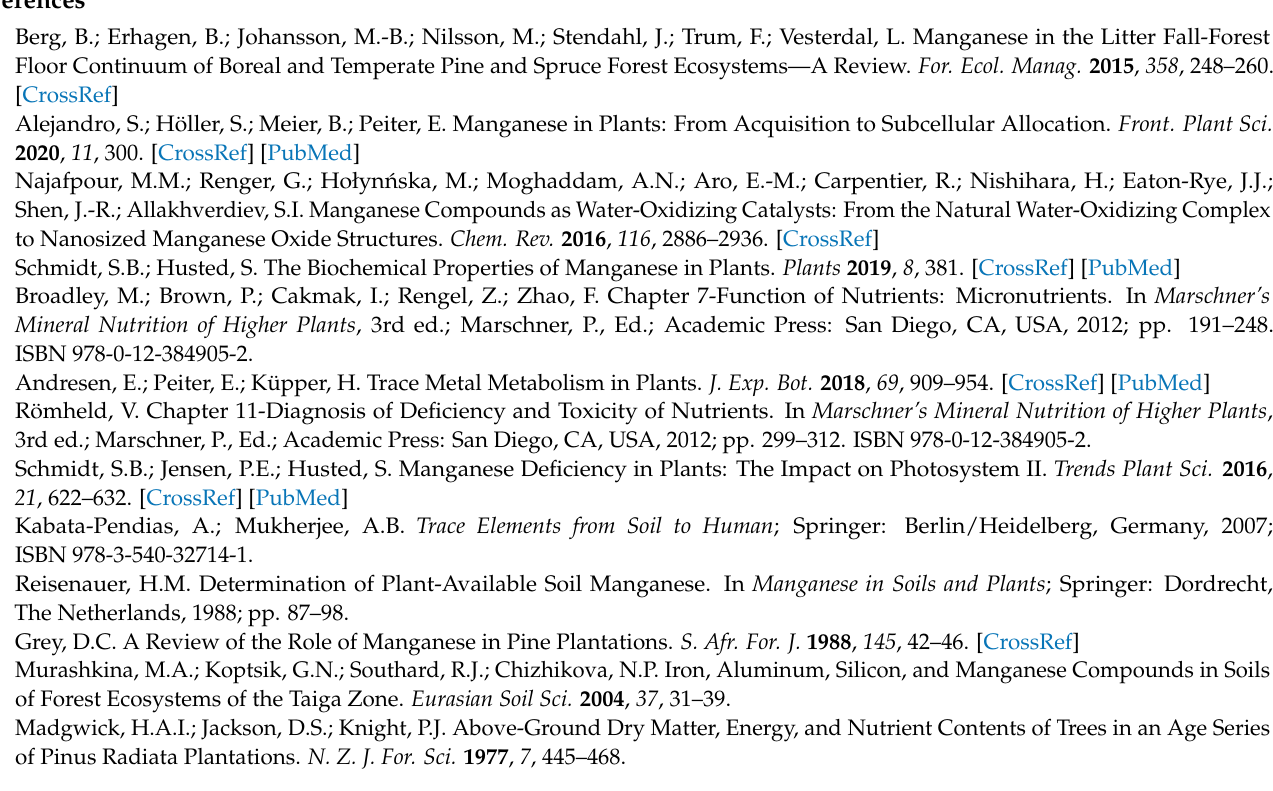
Table S2: The contents of nutrients in the roots of Scots pine seedlings; Table S3: The contents of nutrients in the needles of Scots pine seedlings; Table S4: The transcript levels of photosynthetic genes ( Lhcb2 , psbA , psbB , psbC , psbD , psbO , psbP , psbQ , psbS , petA , petC , petD , petE , Lhca , psaA , psaB and rbcL ), and genes involved in chlorophyll biosynthesis ( porA , chlB , chlL , chlN ) in the needles of Scots pine